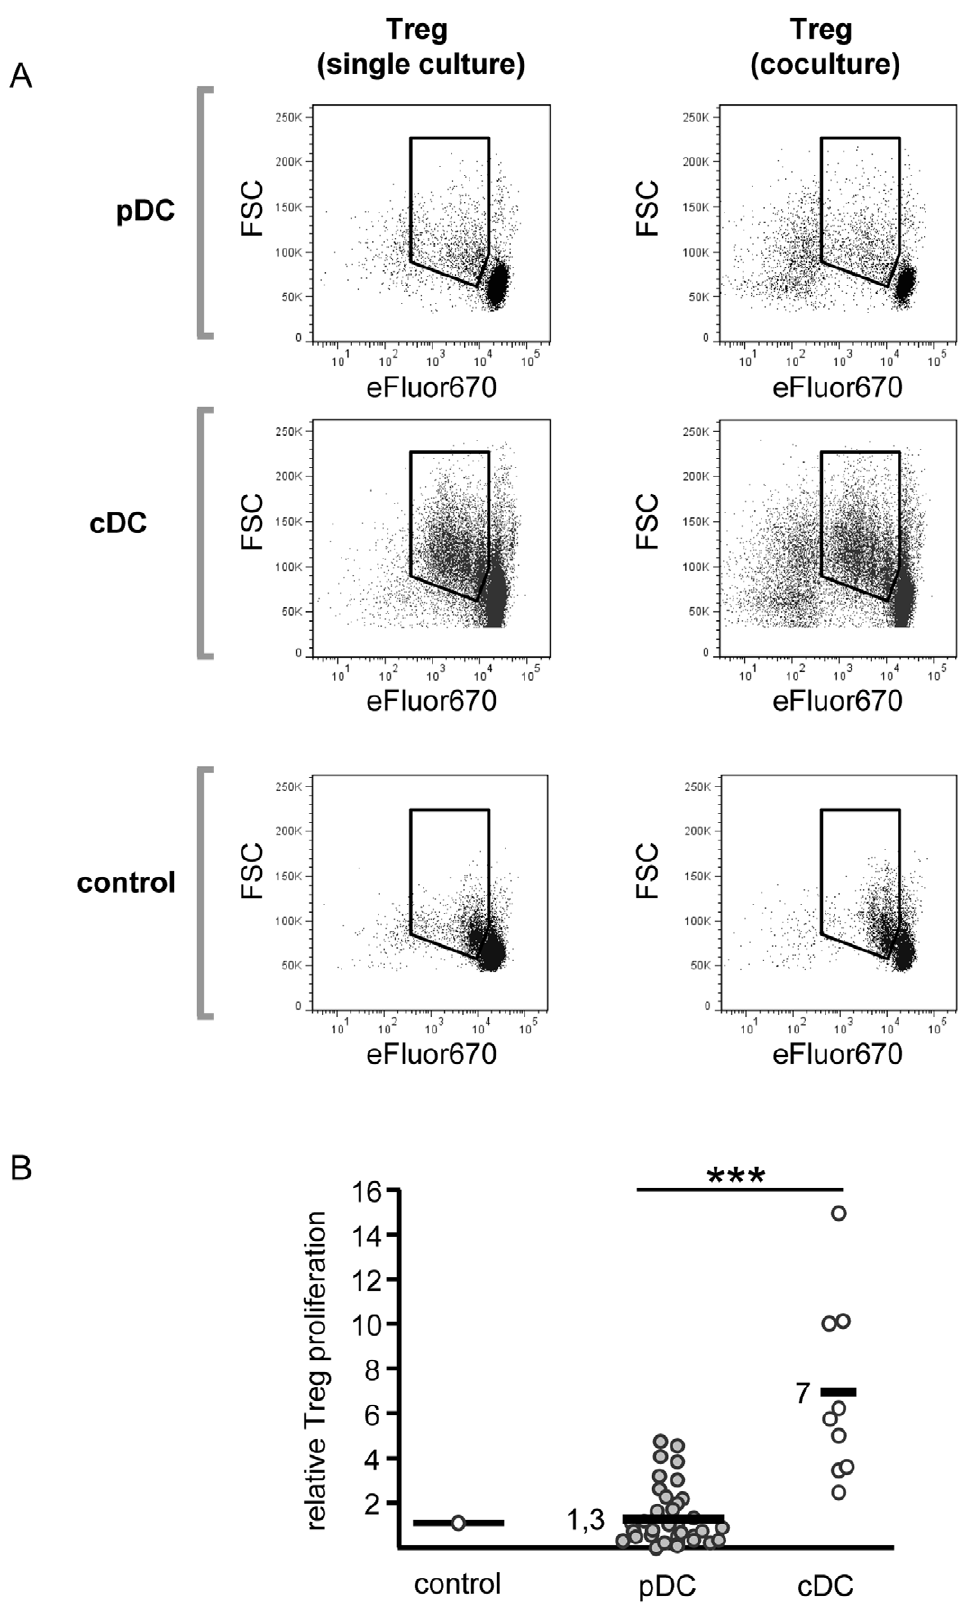
Figure 3. Plasmacytoid dendritic cells are unable to induce proliferation of regulatory T cells. A: Proliferation of DC-stimulated Treg alone or in coculture with Teff. eFluor H 670-labeled Treg were stimulated alone (left panel) or in coculture with CD4 + Teff (ratio 1:1, right panel).